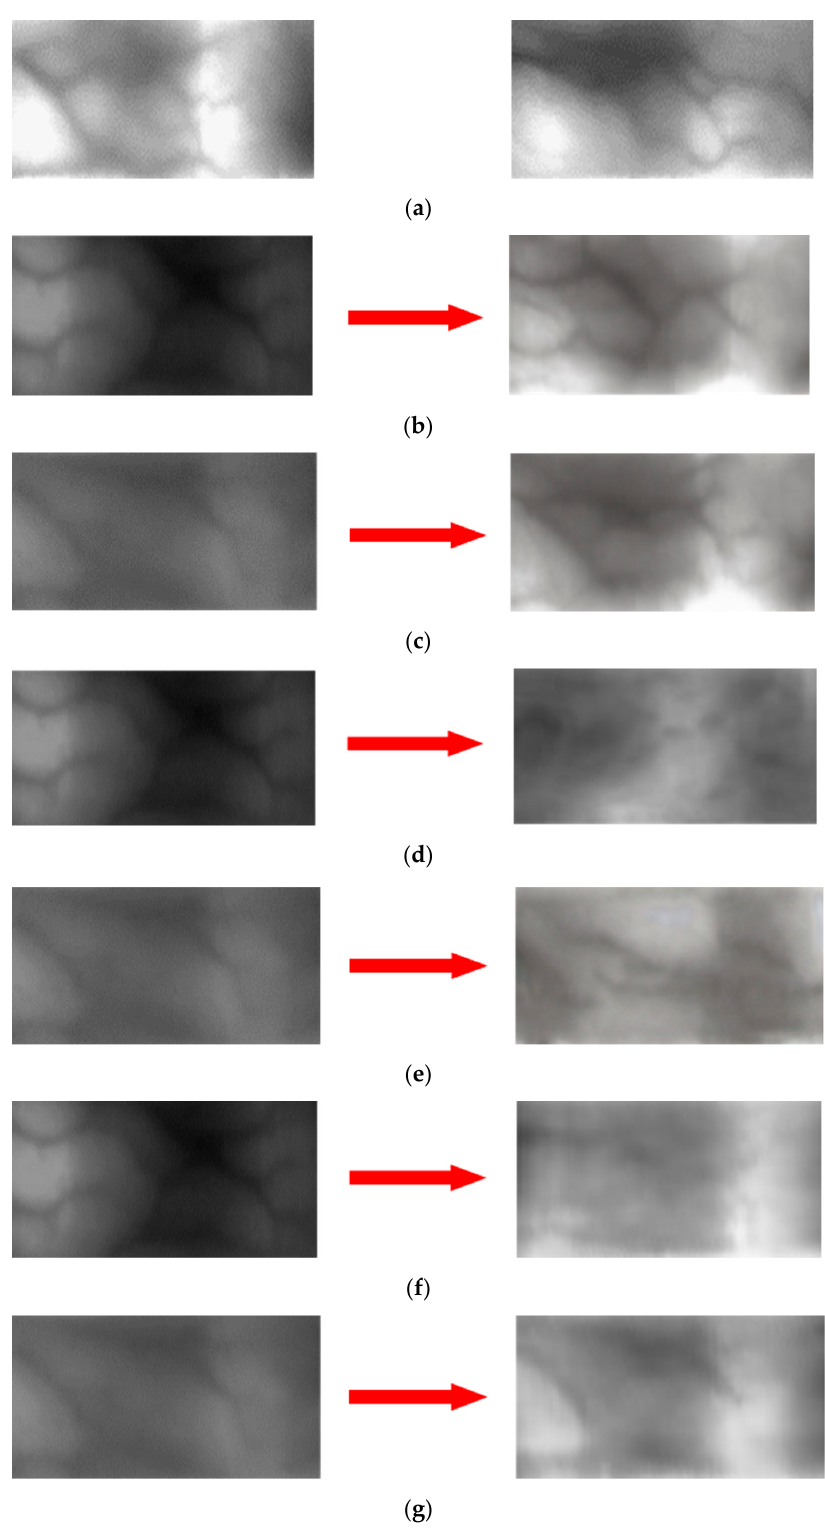
Figure 10. Examples of original images and domain adapted images: ( a ) Original image of HKPolyU-DB. Left and right images of ( b )–( g ) respectively, show original images and domain adapted images from SDUMLA-HMT-DB and HKPolyU-DB using various methods. ( b , c ) proposed method, ( d , e ) ComboGAN, ( f , g ) StarGAN-v2.